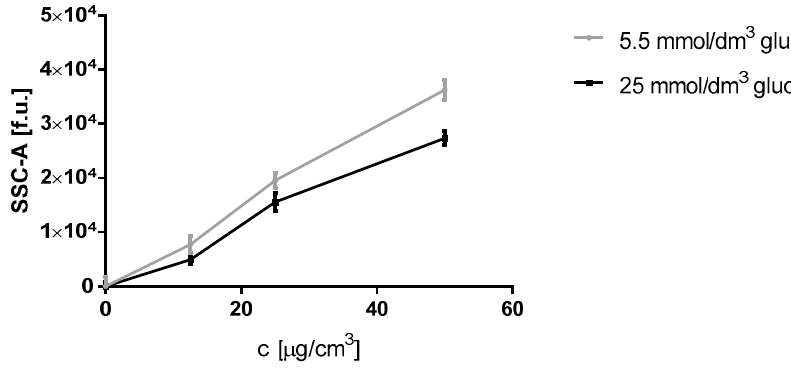
Figure 3. Measurement of the SSC-A parameter in Hep G2 cells (5 × 10 5 cells per well) grown in 5.5 mmol / dm 3 , and 25 mmol / dm 3 glucose media after 4 and h incubation with 12.5, 25, and 50 µ g / cm 3 silver nanoparticles concentrations. Comparisons between cells cultured in media with different glucose concentration was determined by comparison of areas under the curves with Student’s t-test.